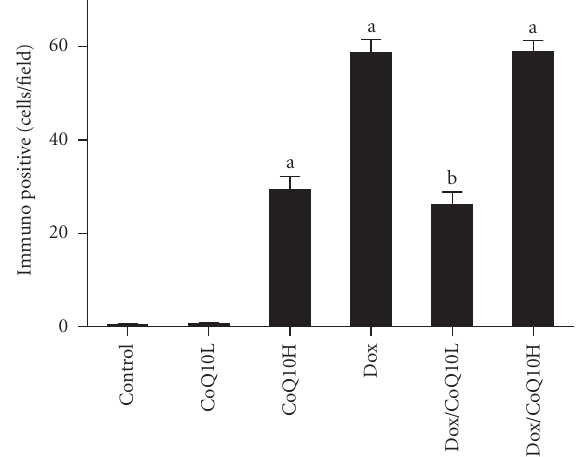
Figure 4: E ff ect of two doses of coenzyme Q10 (CoQ10) on renal caspase 3 immunohistochemical semiquantitative analysis in rats exposed to doxorubicin- (Dox-) induced nephrotoxicity. Kidneys were isolated from control untreated group, animals treated with low or high dose CoQ10 (CoQ10L or CoQ10H, resp.), and animals treated with Dox, or with Dox together with CoQ10L or CoQ10H, respectively. Values are represented as means ± SE of number of immuno-positive cells for caspase 3 in sections of 3 animals of each group, 5 fields/section. a Significant di ff erence compared with control and b significant di ff erence compared to Dox, with significant di ff erence from control. Significant di ff erence is reported when P < 0 .